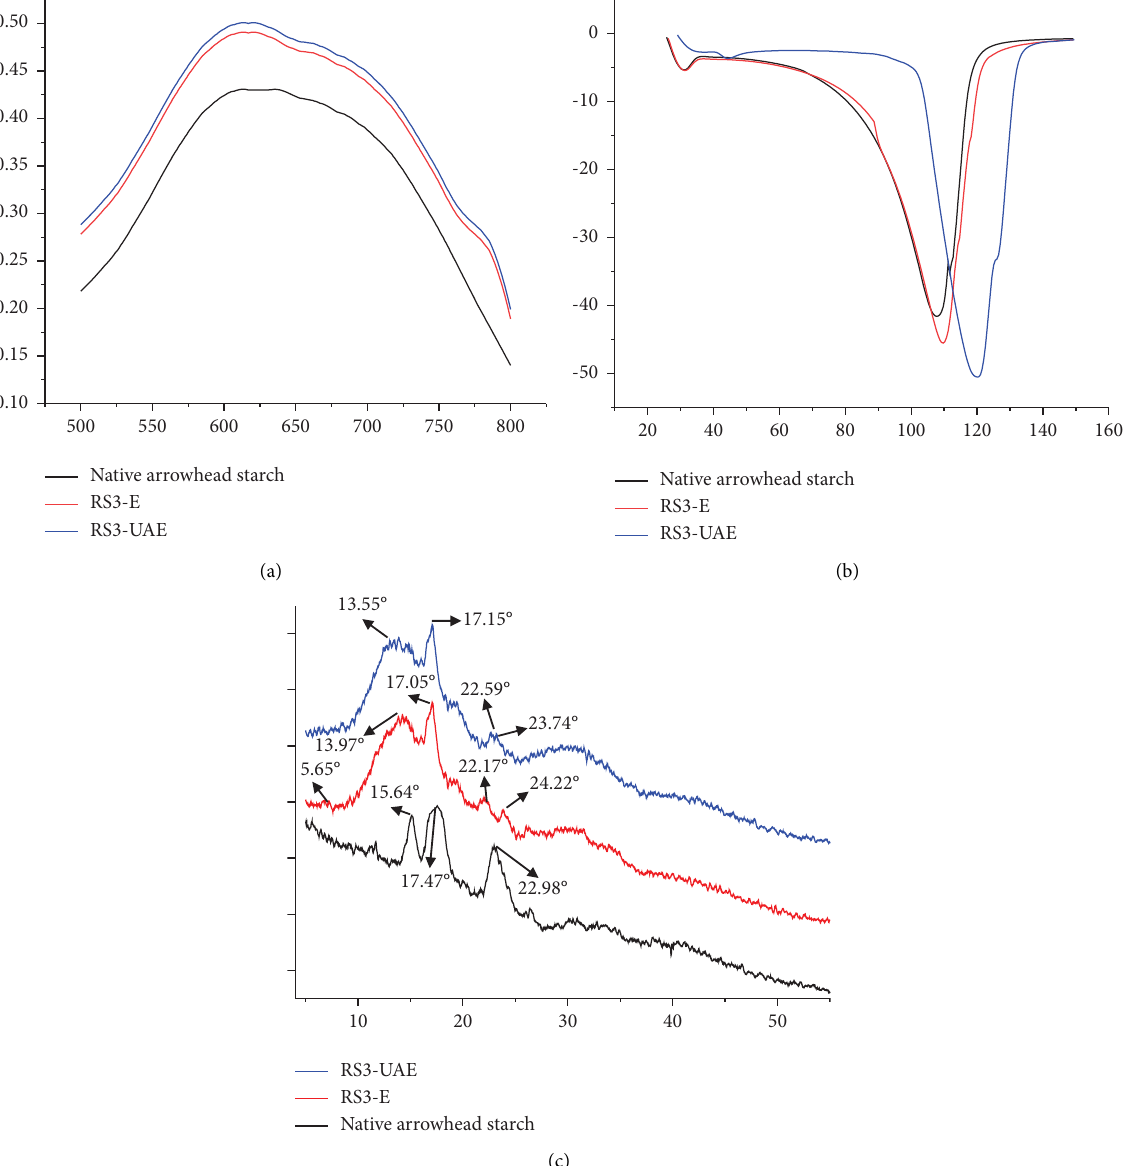
Figure 3: Te iodine absorption curve (a), DSC thermograms (b), and XRD difractograms (c) of arrowhead starch, RS3-E, and RS3-UAE. RS3-E type 3 resistant starch prepared by traditional-enzymolysis; RS3-UAE type 3 resistant starch prepared by ultrasound-assisted